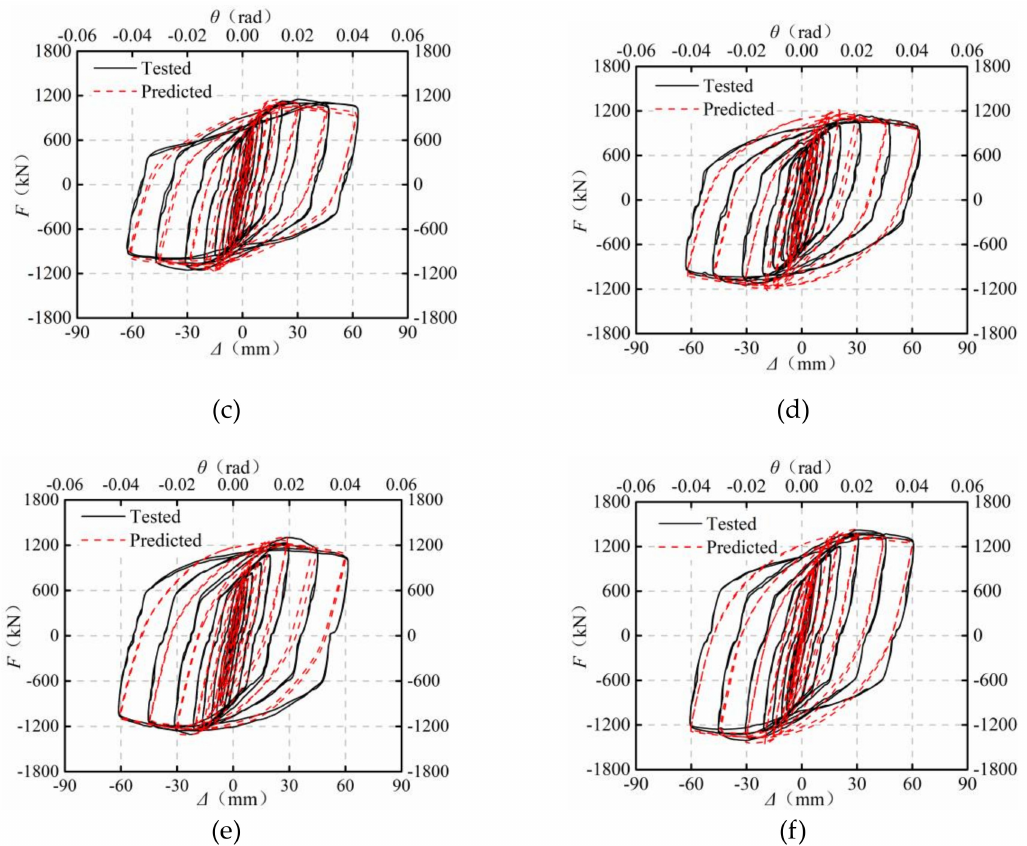
Figure 7. Measured and FEA model load versus displacement relations. ( a ) CFST-N; ( b ) CFST-HS; ( c ) CFST-VS; ( d ) CFST-SR; ( e ) CFST-DT; and ( f )